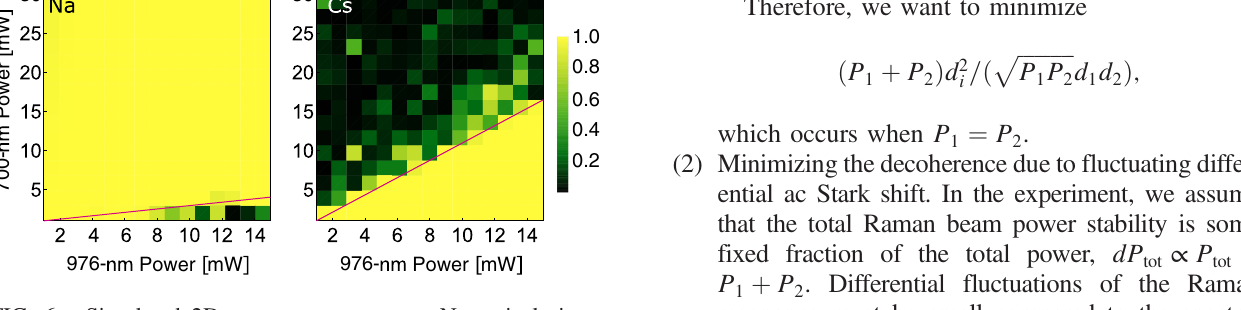
FIG. 6. Simulated 2D tweezer power scan. Numerical simu- lation of the axial ground-state population for Na and Cs following the merge sequence described in Sec. III. All the fundamental heating mechanisms (delineated by purple lines) are qualitatively reproduced.